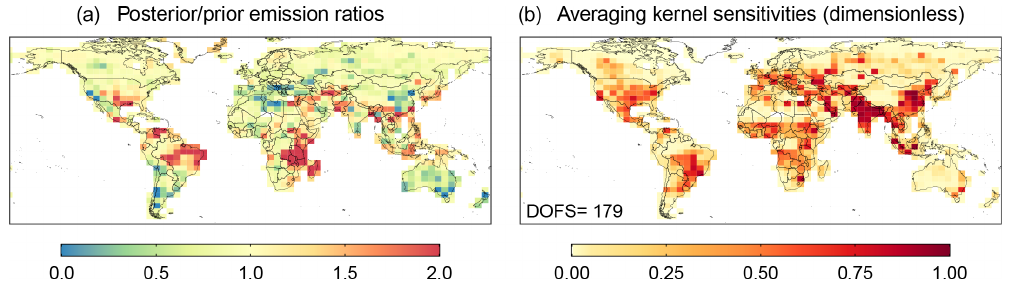
Figure 7. Corrections to prior estimates of 2010–2018 mean non-wetland methane emissions. (a) Posterior-to-prior emission ratios. Figure S7 shows the same corrections as posterior–prior emission differences. (b) Averaging kernel sensitivities (diagonal elements of the averaging kernel matrix). The averaging kernel sensitivities measure the ability of the observations to constrain the posterior solution (0: not at all, 1: fully). The sum of averaging kernel sensitivities defines the degrees of freedom for signal (DOFS), which is inset.